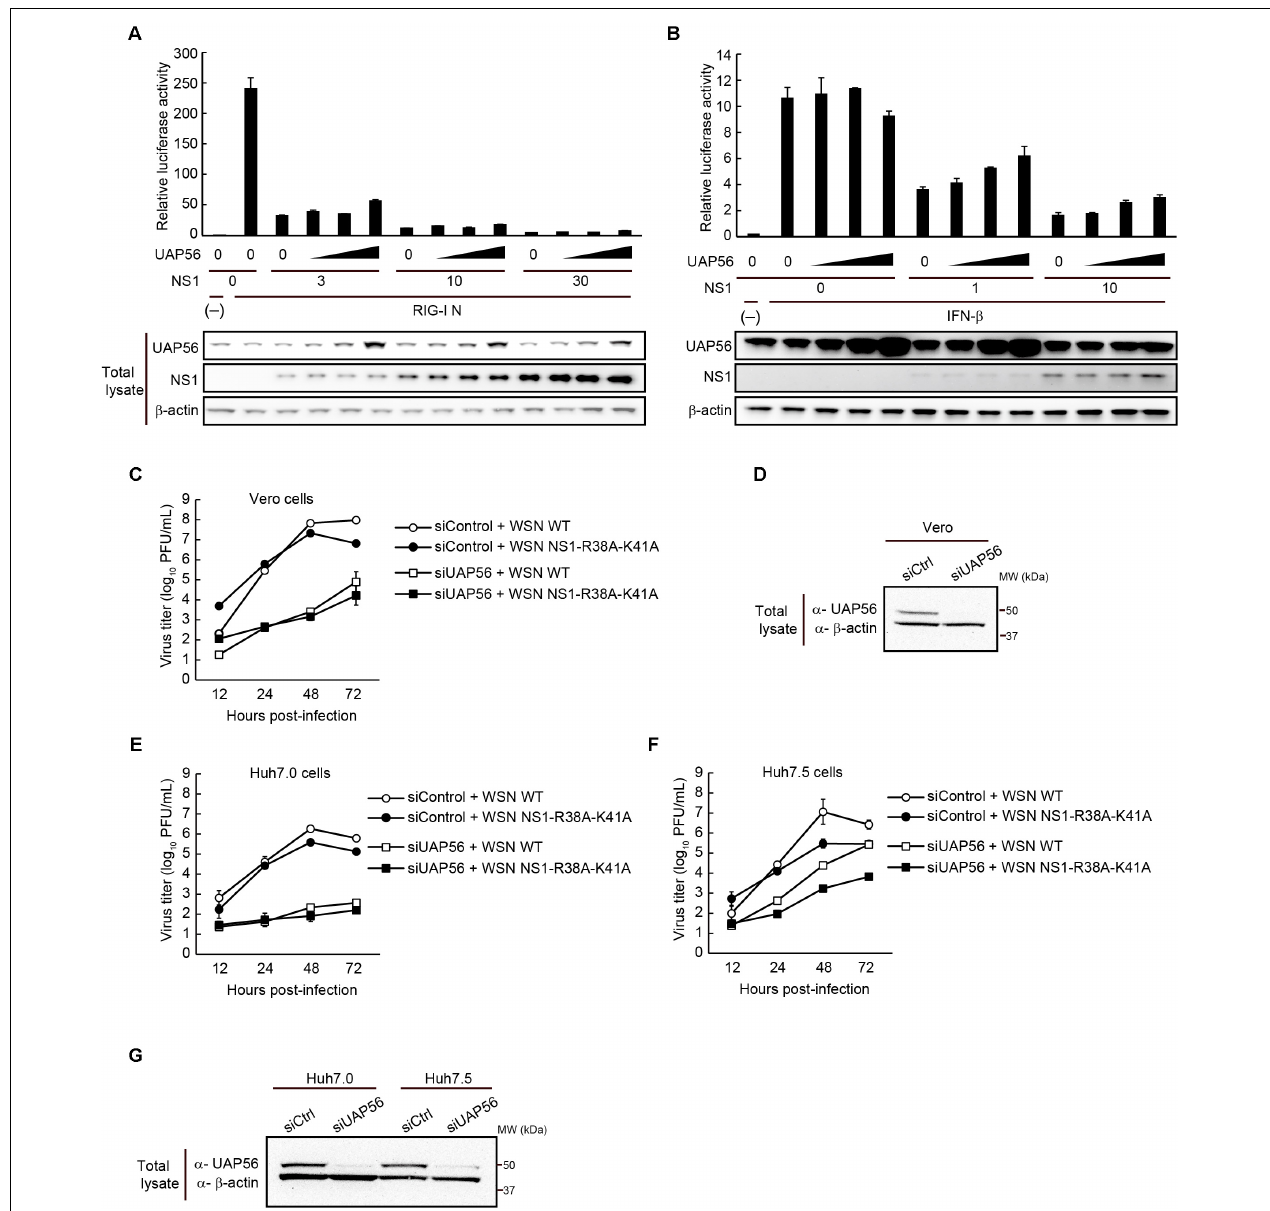
FIGURE 5 | Effect of UAP56 overexpression on the IFN-antagonist activity of NS1. (A) UAP56 overexpression does not affect NS1’s ability to suppress IFN- β promoter activity. HEK293T cells were transfected with plasmids expressing firefly luciferase under the control of an IFN- β promoter, pRL-TK luciferase (as an internal control), a constitutively active form of RIG-I (pCAGGS-RIG-I N), increasing amounts of pCAGGS-NS1 (0, 3, 10, or 30 ng), and pCAGGS-UAP56 (0, 3, 10, or 30 ng). Twenty-four hours later, the cells were lyzed and firefly and Renilla luciferase activities were measured. The firefly luciferase activity was normalized by the internal control value. The total amount of transfected vector was adjusted in all wells using the pCAGGS control vector. Data are shown as the mean ± SD ( n = 3; biological replicates). UAP56 and NS1 expression levels in cells were examined by immunoblotting. (B) UAP56 overexpression does not affect NS1’s ability to suppress ISRE-driven gene expression. HEK293T cells were transfected with plasmids expressing firefly luciferase under the control of an ISRE promoter element, pRL-TK luciferase (as an internal control), and increasing amounts of pCAGGS-NS1 (0, 1, or 10 ng) and pCAGGS-UAP56 (0, 3, 10, or 30 ng). Twenty-four hours later, the cells were mock-treated or treated with IFN- β (10,000 U/mL), and cultured for 24 h. Luciferase activities were measured and data were analyzed as described in A . Data are shown as the mean ± SD ( n = 3; biological replicates). UAP56 and NS1 expression levels in cells were examined by immunoblotting. (C–G) WSN virus or WSN-NS1-R38A-K41A mutant virus replication in cells transfected with siRNA targeting UAP56 or with a control siRNA. Vero (C) , Huh7.0 (E) , or Huh7.5 (F) cells were transfected with siRNA targeting UAP56, or a control siRNA. At 24 (Vero cells) or 48 h (Huh7.0 and Huh7.5 cells) post-transfection, the cells were infected with WSN virus or WSN-NS1-R38A-K41A mutant virus at an MOI of 0.01 and incubated at 37 ◦ C. Culture supernatants were collected at the indicated times post-infection and viral titers were analyzed by performing plaque assays in MDCK cells. The data are shown as the mean ± SD ( n = 3; biological replicates). Levels of UAP56 expression in Vero (D) or Huh7.0 and Huh7.5 (G) cells transfected with siRNA targeting UAP56, or with a control siRNA. UAP56 expression levels were analyzed by immunoblotting at 48 (Vero cells) or 72 h (Huh7.0 and Huh7.5 cells) after siRNA transfection.